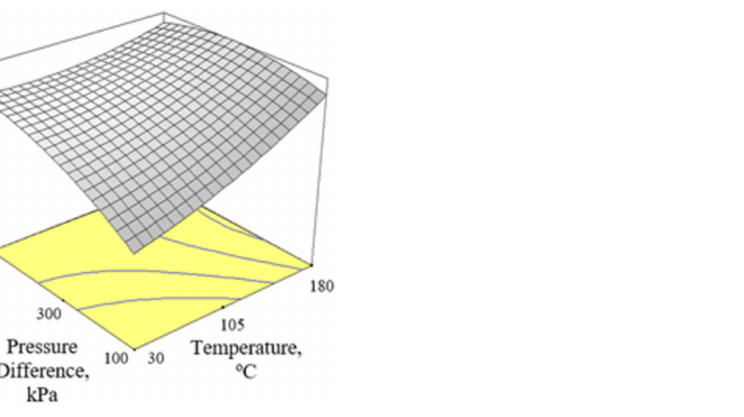
Figure 2. Effect of interaction between temperature and pressure difference on the 1/(CO 2 permeance) at 27.5% CO 2 in the